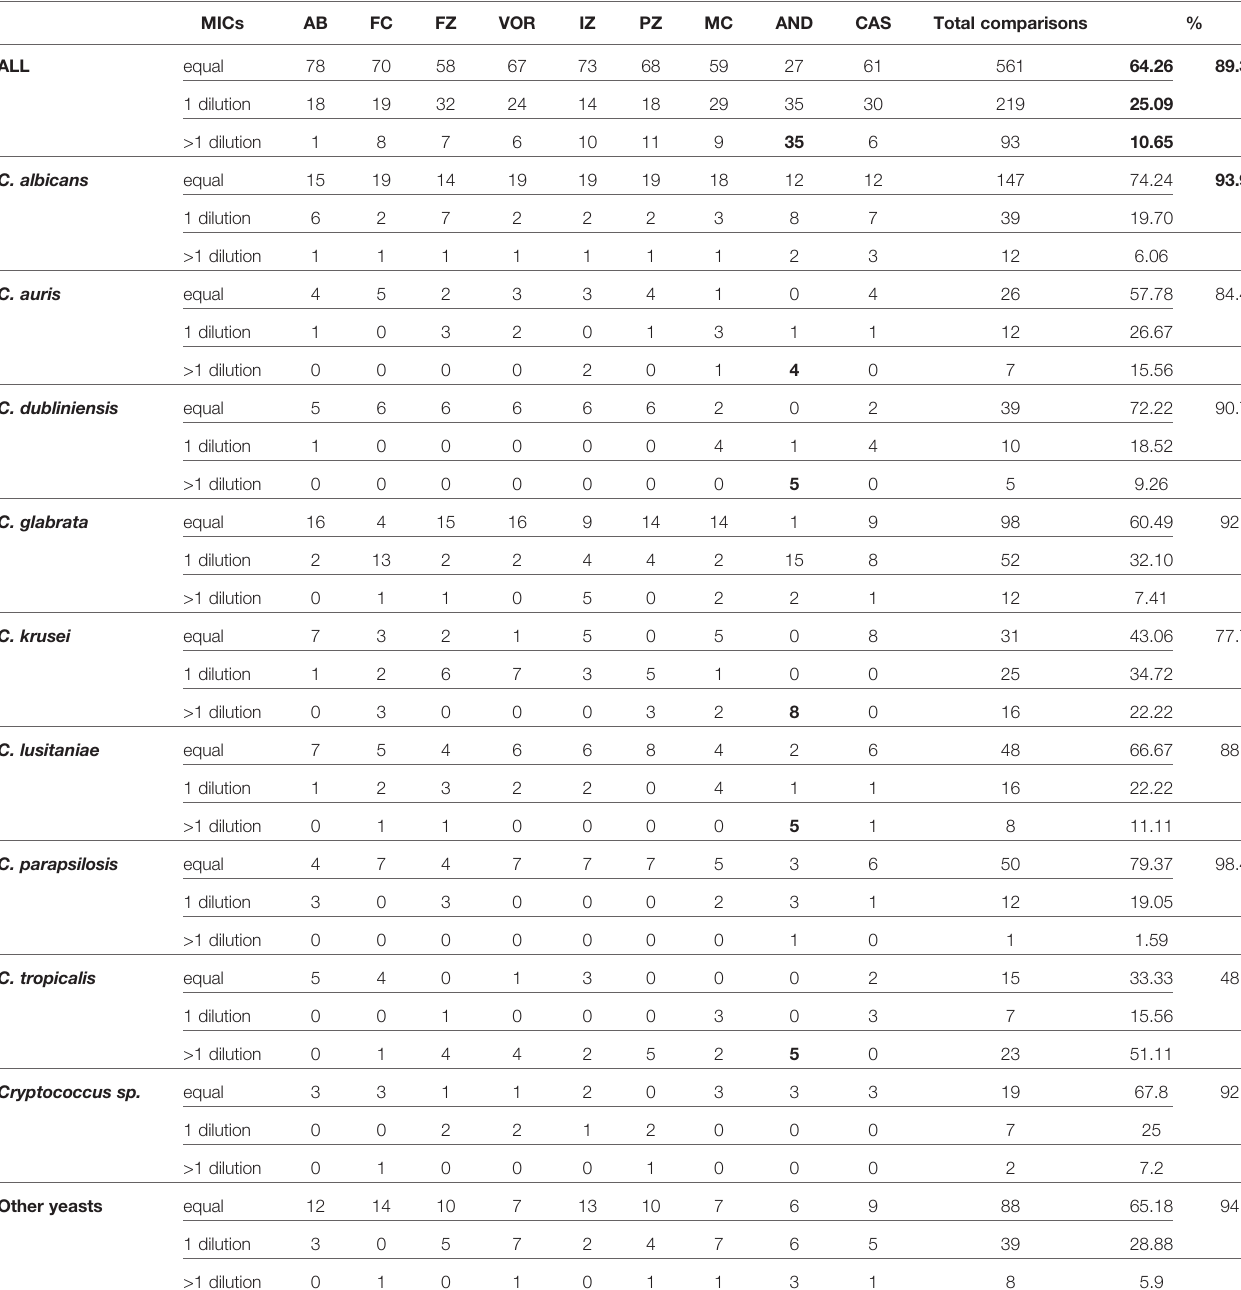
TABLE 1B | Comparisons of MIC between Micronaut-AM read visually and